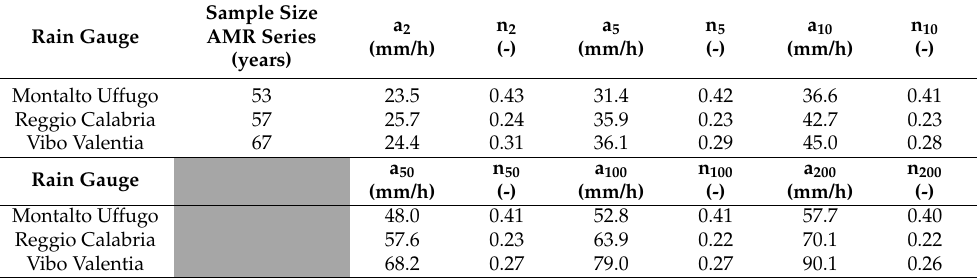
Figure 15. Comparison among synthetic and observed summary statistics. For the sake of brevity, focusing on specific rain gauge data series, examples of STORAGE application are below described for Montalto Uffugo, Reggio Calabria and Vibo Valentia stations. Their associated sample values for the statistical descriptors are reported in Tables 2 and 3. Table 2. Montalto Uffugo, Reggio Calabria and Vibo Valentia rain gauges: values of parameters concerning ADF